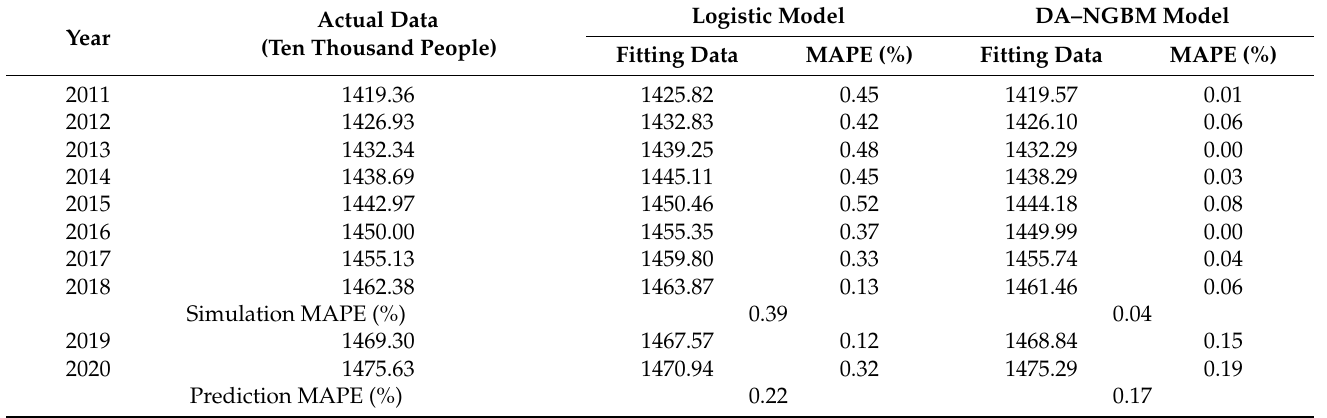
Table 2. Comparison between Logistic model and DA–NGBM model of registered population of